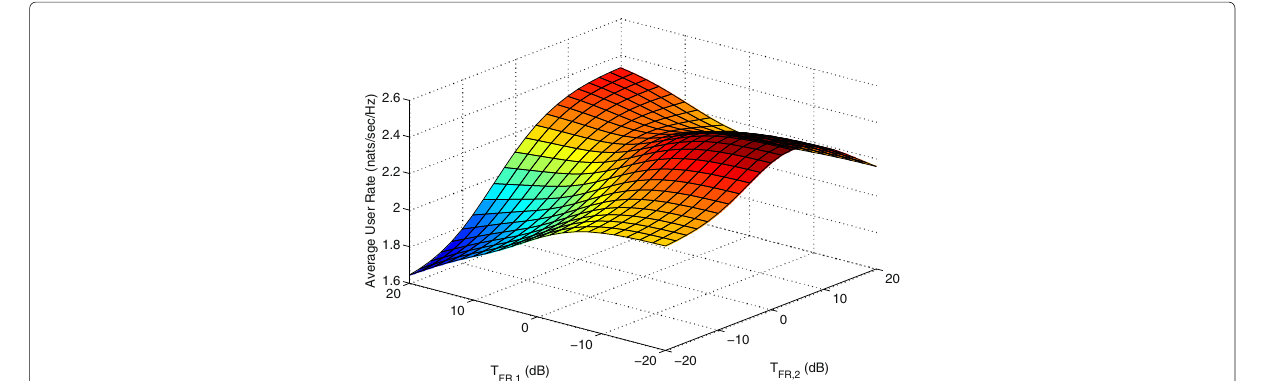
Fig. 7 Effect of SFR thresholds T FR,1 and T FR,2 on average user rate with B = 10 dB, β = 0.2, and η =